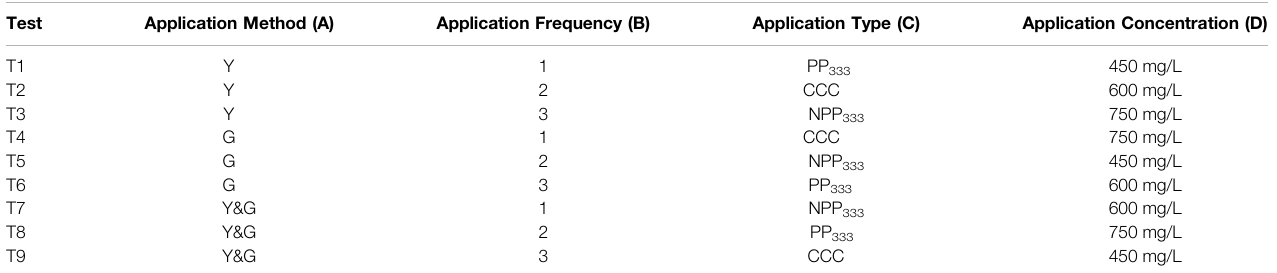
TABLE 2 | Orthogonal Test Design